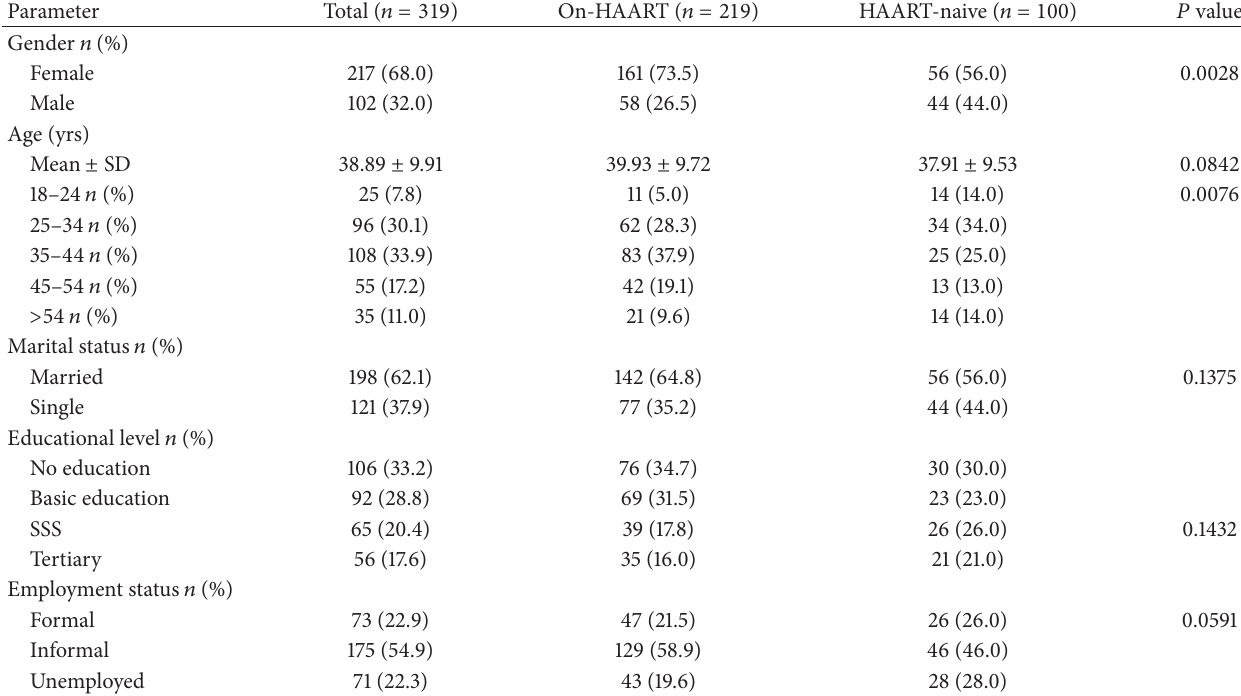
Table 1: Sociodemographic characteristic of the study population.